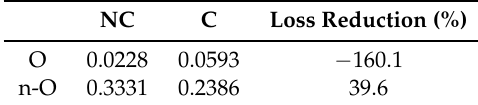
Table 9. Losses under symmetric